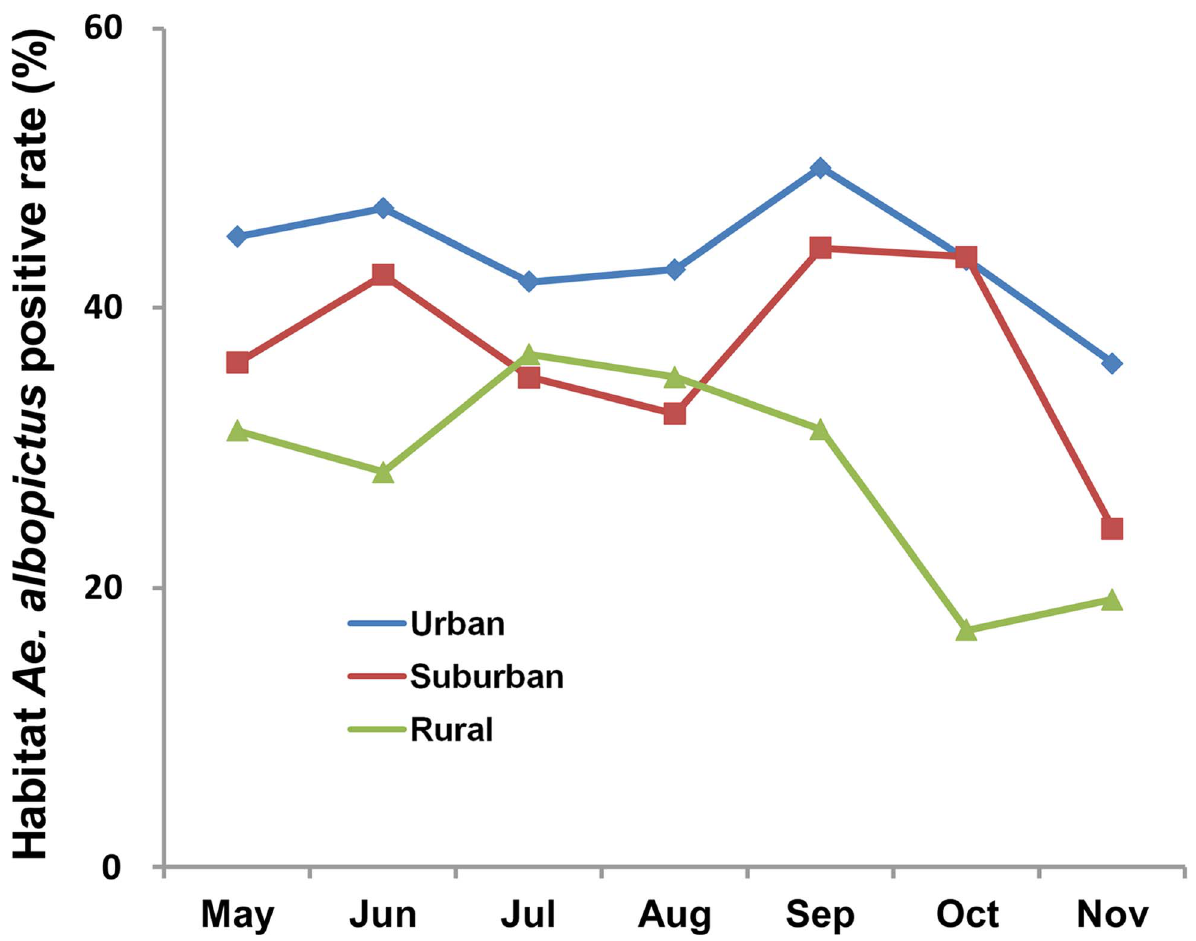
Figure 2. Seasonal shifts in Ae.albopictus habitats in different areas.